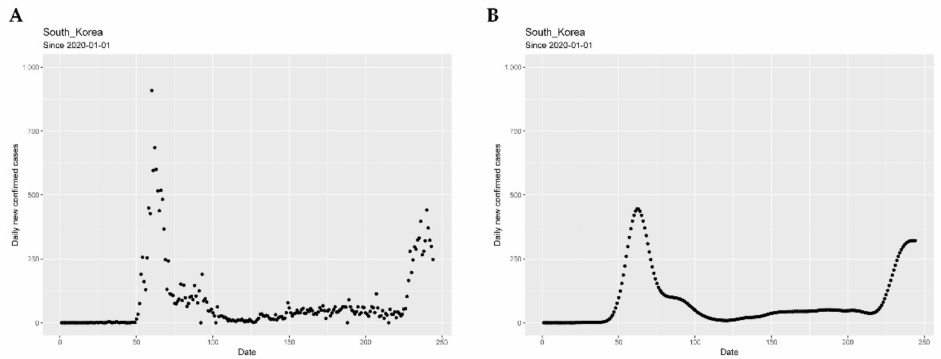
Figure 2. Daily new confirmed cases before ( A ) and after smoothing using Nadaraya–Watson kernel regression ( B